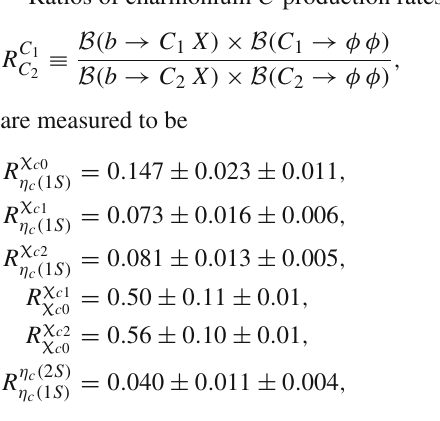
→ φφφ decay. In order to search for contributions from B 0 s